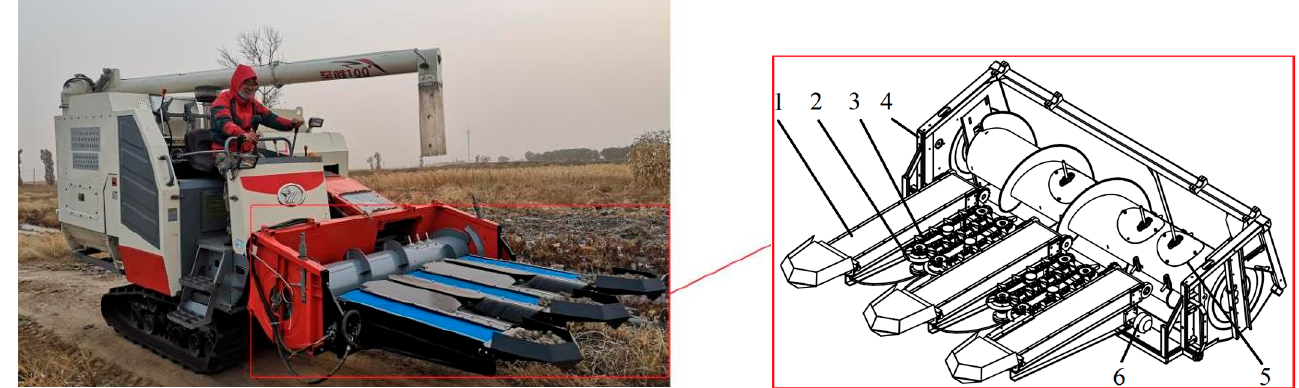
Figure 1. Castor harvester picking device. 1. Capsule recycling mechanism; 2. double-disc cutting system; 3. dial teeth chain; 4. frame; 5. horizontal auger; 6. transmission system.